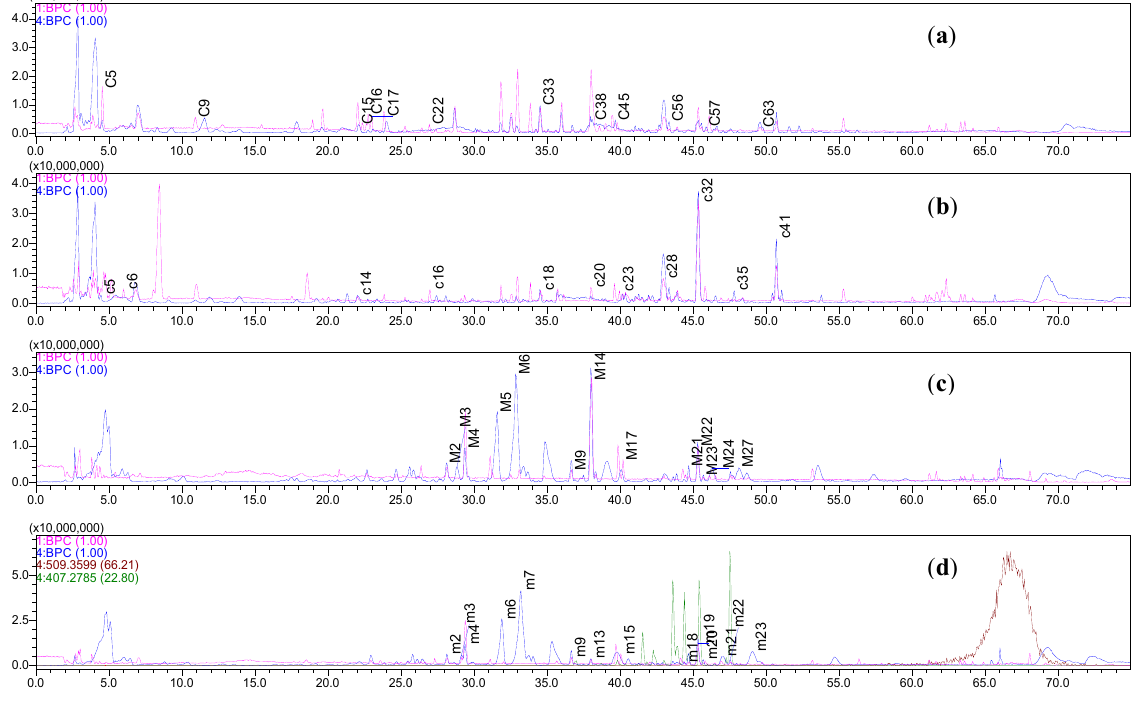
Figure 3. ( a ) The BPC in NI and PI mode of the crude extracts of Danggui Buxue Tang 1 (RA:RAS = 5:1). ( b ) The BPC in NI and PI mode of the crude extracts of Danggui Buxue Tang2 (RH:RAS = 5:1). ( c ) The BPC in NI and PI mode of the urine samples of rats that had been administrated the Danggui Buxue Tang 1 (RA:RAS = 5:1) and ( d ) The BPC in NI and PI mode of the urine samples of rats had been administrated the Danggui